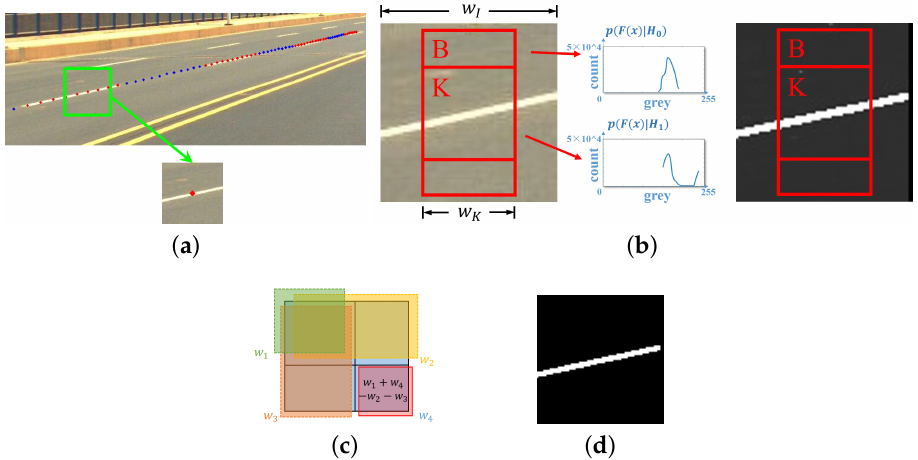
Figure 16. A case of textural saliency analysis. ( a ) The green box is a square buffer around the sampling point. After the textural saliency analysis of each buffer, there are 39 salient points (red), and 31 points that are not salient (blue). The lane line in this picture is valid since m / n > 50%. ( b ) A detector window is divided into the kernel window K and the border window B , which are marked with a red border. The pictures in the middle are the distribution of pixels in windows B and K , the contrast of which determines the saliency. On the right is the saliency value in the window. ( c ) The grayscale histograms in the green, yellow, orange and blue regions are denoted w 1 , w 2 , w 3 , w 4 , respectively, which are also the values of the four corners of the red region in the integral histogram. The gray value histogram in the red region can be quickly calculated by w 1 + w 4 − w 2 − w 3 . ( d ) The saliency values in the buffer in ( a ) after thresholding.